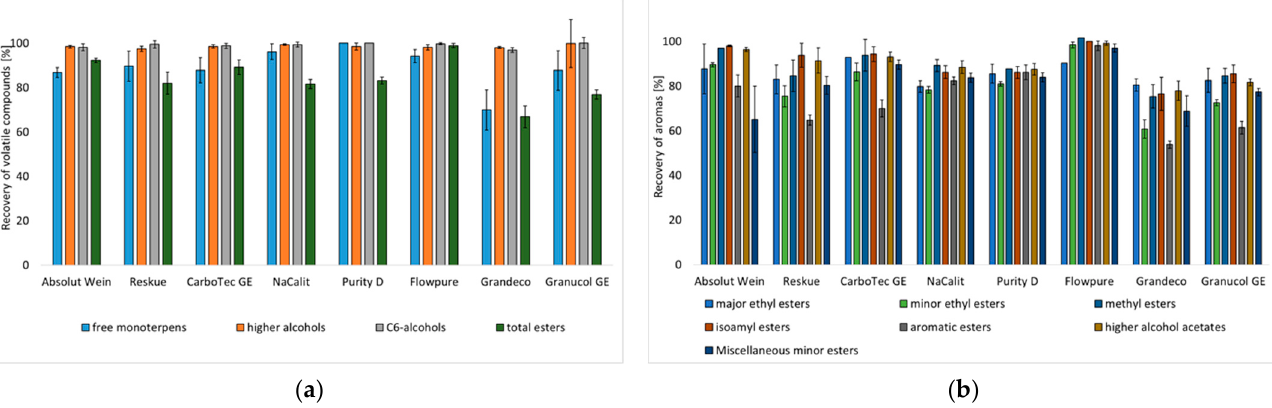
Figure 5. Recovery of volatile substances after fining in red wine; ( a ) main groups: free monoterpenes, higher alcohols, C6-alcohols and total esters; ( b ) specific ester groups: major ethyl esters, minor ethyl esters, methyl esters, isoamyl esters, aromatic esters, higher alcohol acetates, miscellaneous minor esters.